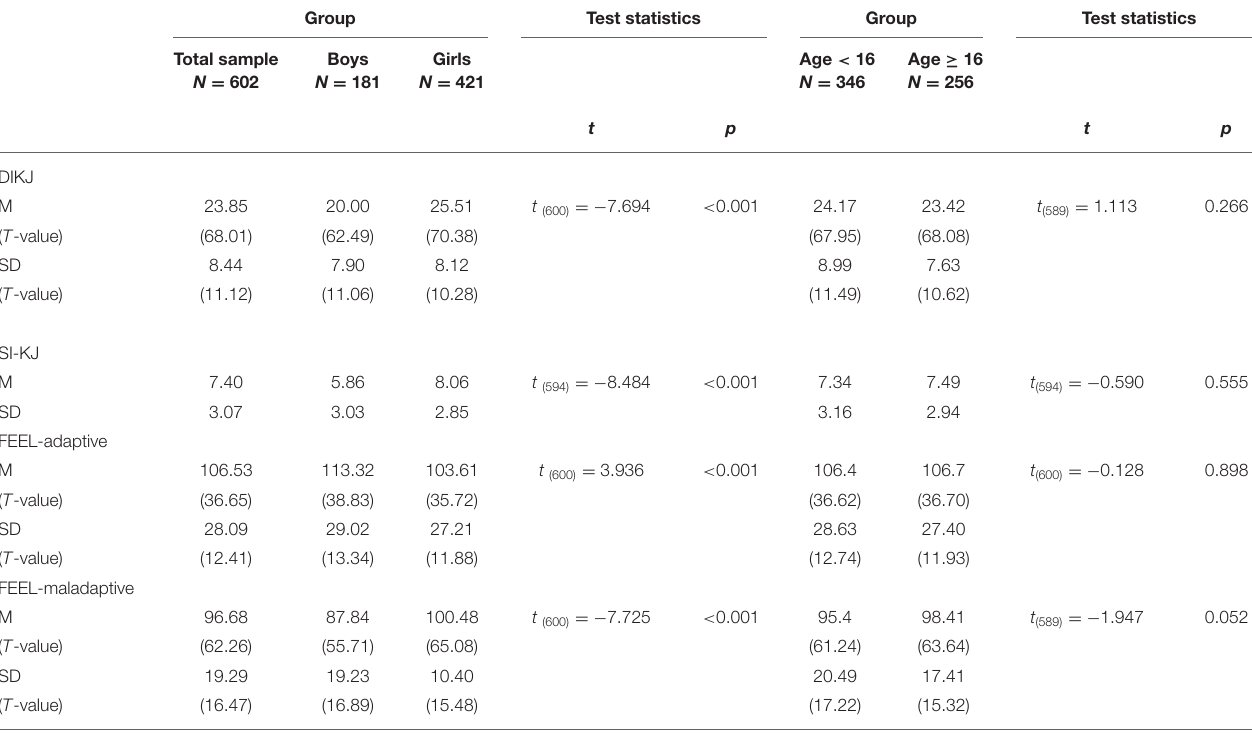
TABLE 1 | Sample characteristics (sum scores, T- values in brackets) regarding sleep, emotion regulation and depressive symptoms. Group Test statistics Group Test